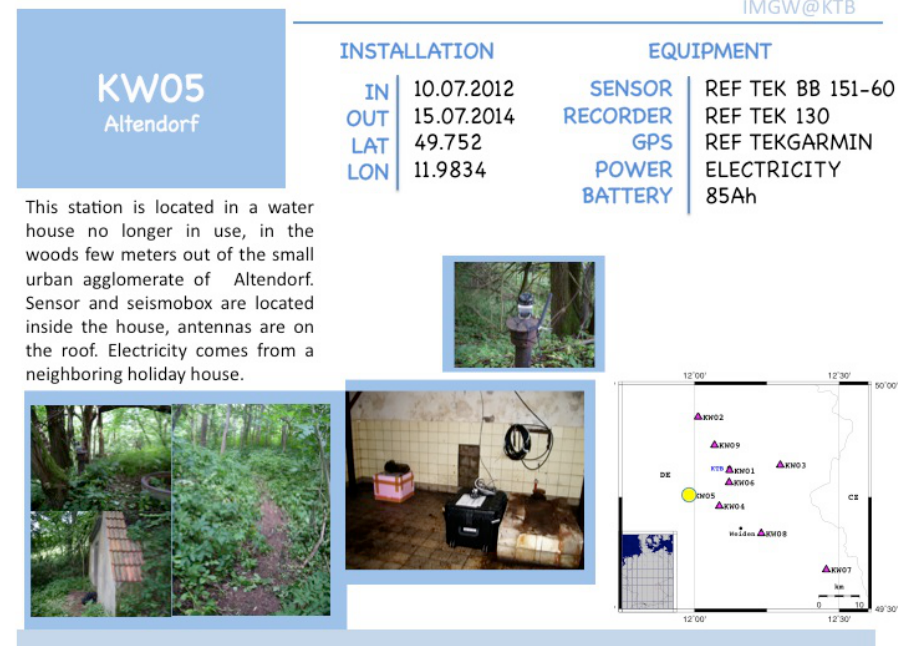
Figure A5. Station KW05 technical information.